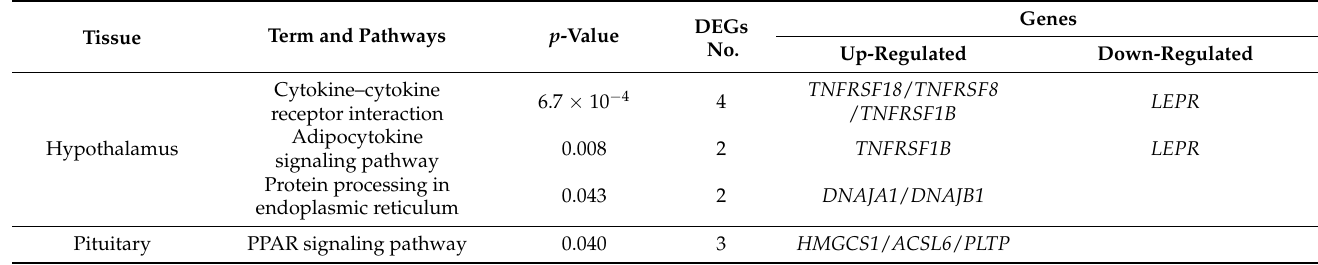
Figure 5. The scatter plot of KEGG pathway analysis. The enriched KEGG pathway of DEGs in the hypothalamus ( a ), pituitary ( b ), thigh muscle ( c ), and liver ( d ). Table 2. The significantly enriched KEGG pathway and related differential genes in each